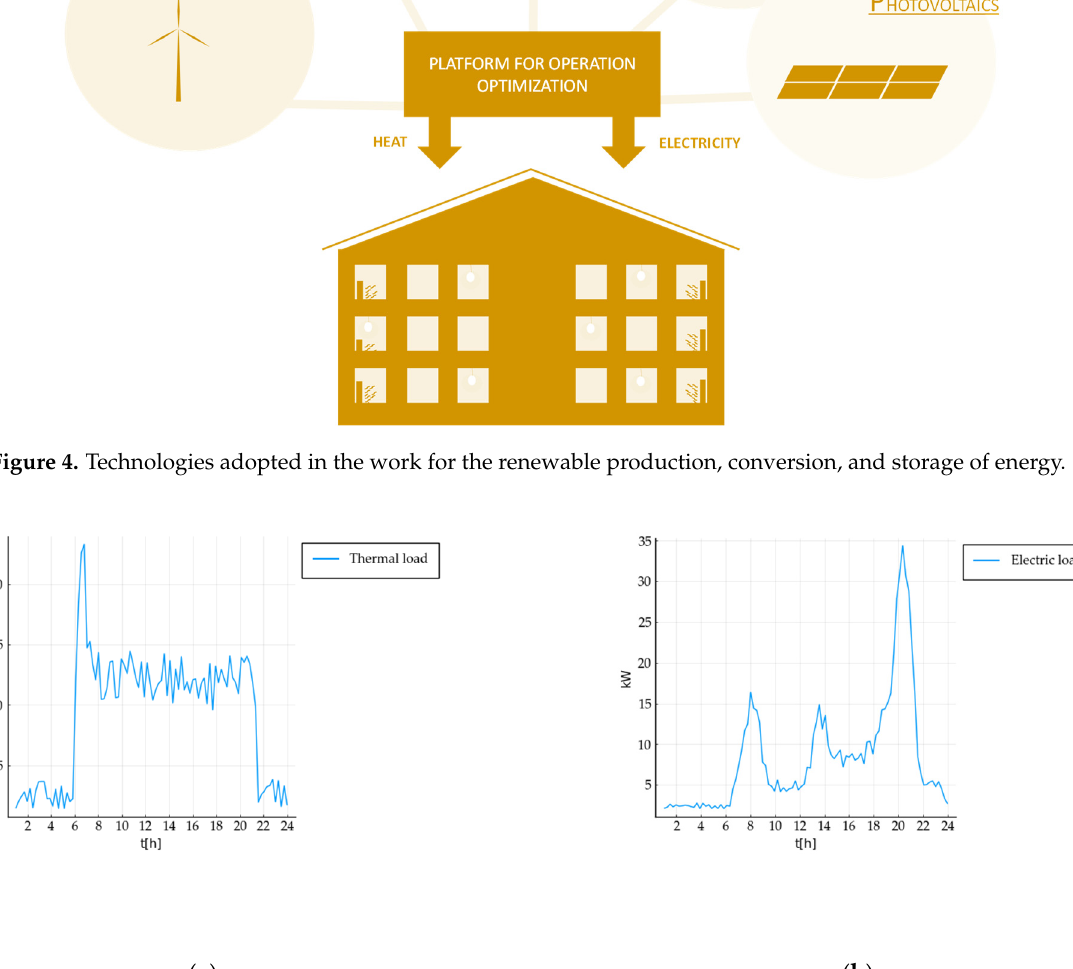
Figure 4. Technologies adopted in the work for the renewable production, conversion, and storage of energy.